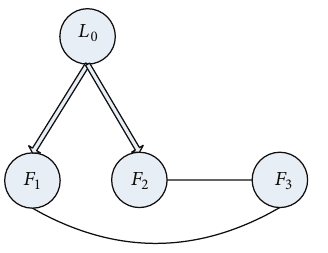
Figure 1: The undirected graph for a group of three followers with a leader. Here 𝐿 0 denotes the leader and 𝐹 𝑖 , 𝑖 = 1, 2,3 , denote the followers. The direct arrows represent the information flow from the leader to the follower and the indirect edges represent the bidirectional information flow between followers.